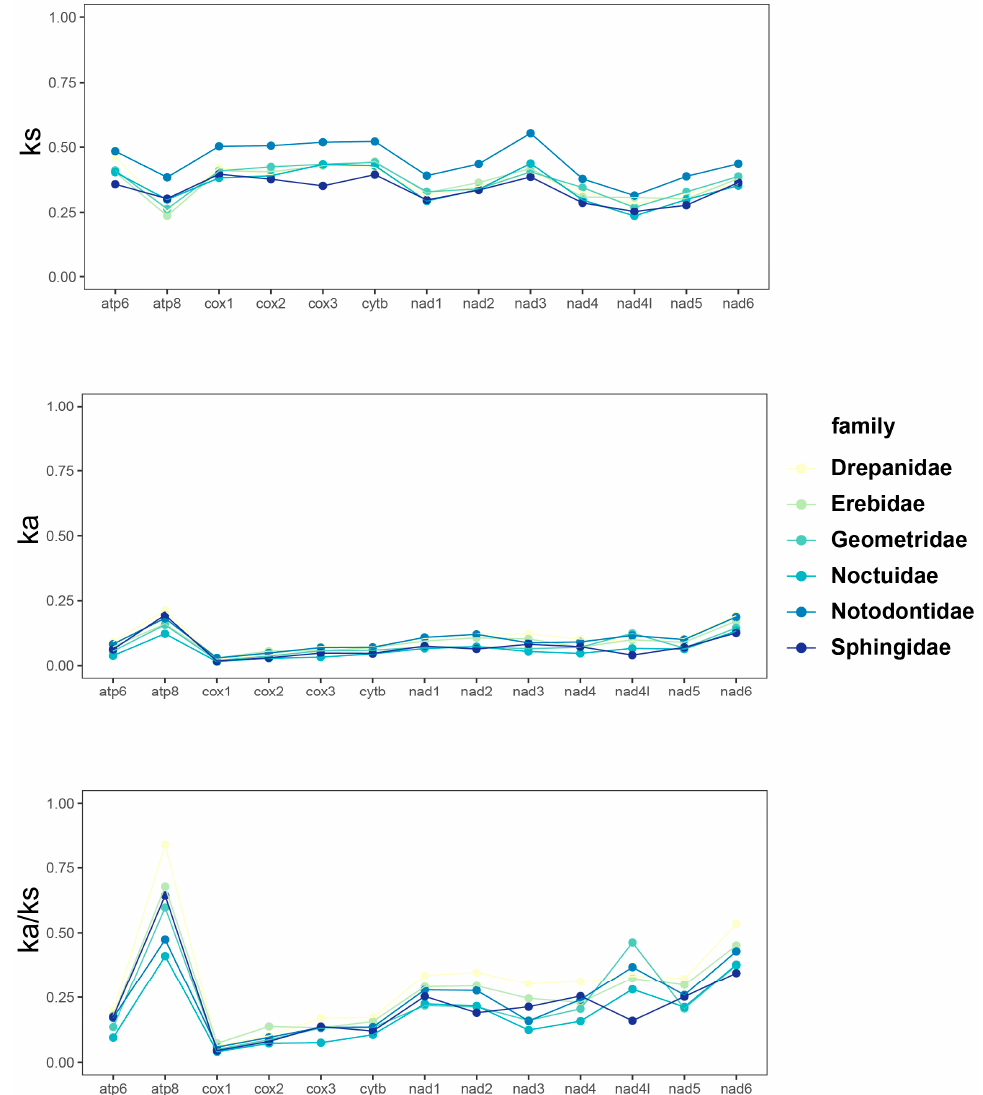
Figure 4. Synonymous and non-synonymous substitutional rates and the ratios of Ka/Ks of protein coding genes. Ka, non-synonymous substitutional rate; Ks, synonymous substitutional rate.